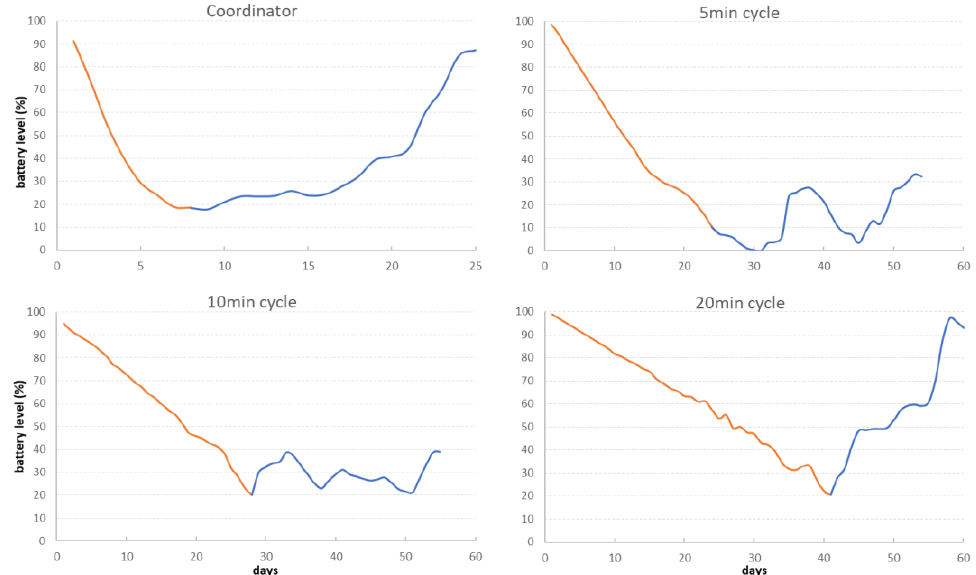
Figure 3. Energy depletion (red line – nodes powered solely by battery) and charging rate (blue line – nodes’ batteries being charged by solar panels) for the coordinator (always on) and for the End - Nodes based on the data acquisition time intervals (5-, 10-, and 20-min cycle).